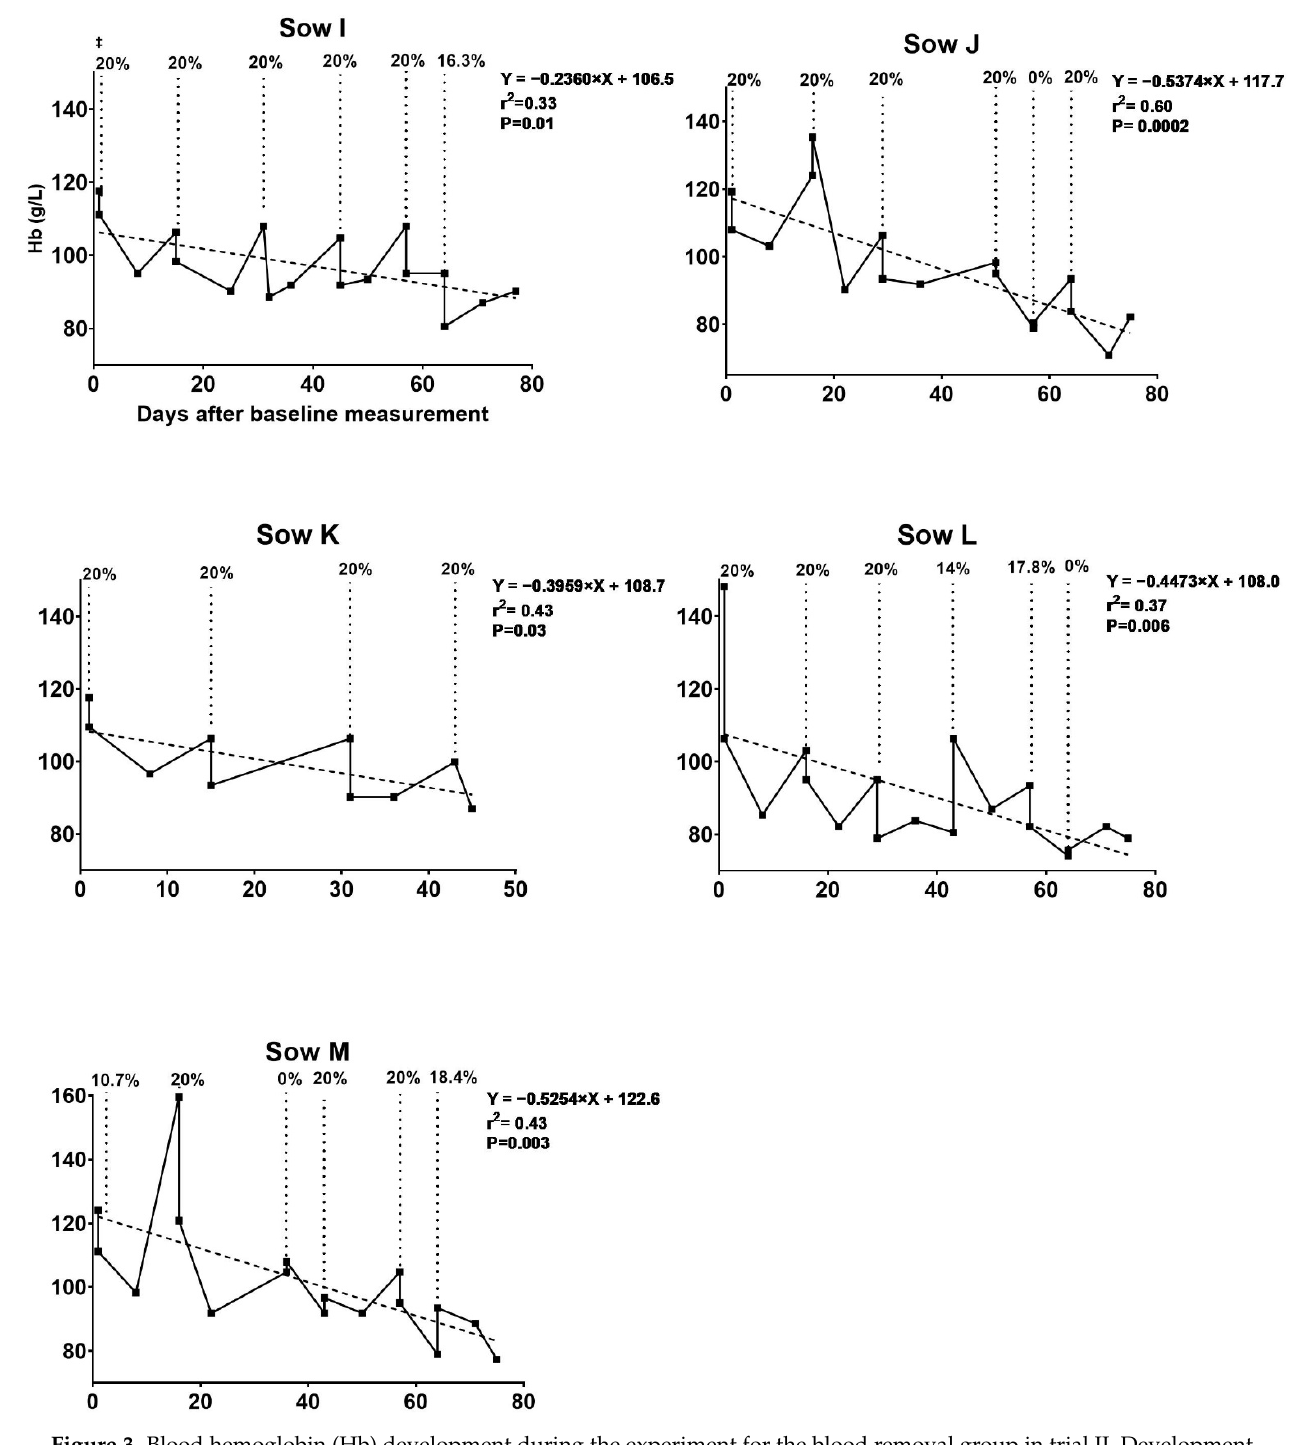
Figure 3. Blood hemoglobin (Hb) development during the experiment for the blood removal group in trial II. Development in blood Hb levels in response to blood removal in gestational sows fed an iron-reduced diet. Five sows were subjected to four to six rounds of blood removal from gestation day 42–44. ‡ Percentages of total blood volume removed at each procedure illustrated by the dotted line. The target Hb level at blood removal was 80 g/L. No blood was removed if Hb was 80 g/L before the procedure. A maximum of 20% of the blood volume was removed during each procedure. The regression line illustrates the gradual decrease in Hb over time. Sow K aborted after the fourth blood removal procedure and was therefore excluded from this point.